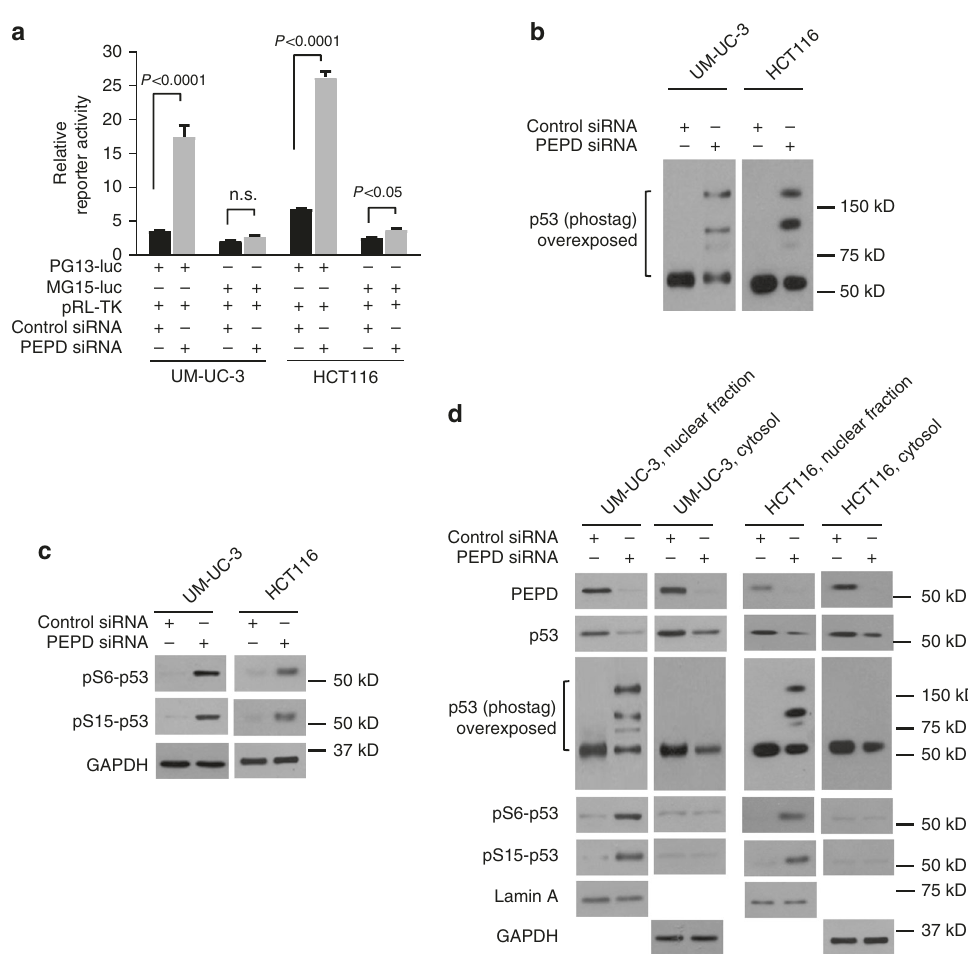
Fig. 4 PEPD inhibits transcription function of p53. a Reporter activity in cells after plasmid transfection for 24h and then treatment with siRNA for 48h. b , c Phos-tag IB analysis and IB analysis of p53 phosphorylation in cells treated with siRNA for 72h. d IB analysis of various proteins in nuclear fraction and cytosol of cells treated with siRNA for 72h. Lamin A and GAPDH were measured as loading controls. Cells were cultured in 6-well plates (5 – 10×10 4 cells/well) for 24h before experimental treatment. Data are means ± s.d. ( n = 3) in a ; two-way ANOVA followed by Tukey multiple comparisons test; n.s., not signi fi